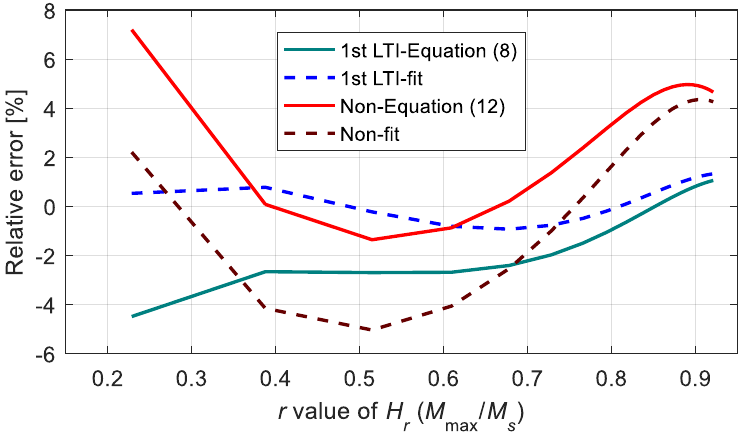
Figure 19. Relative errors on computing the magnetization amplitude.